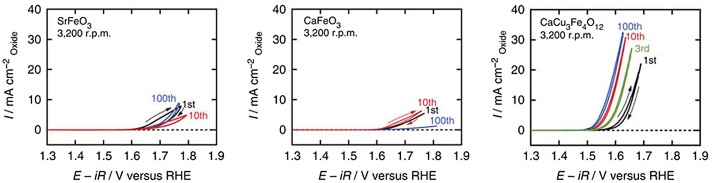
Cyclic voltammograms of SrFeO3, CaFeO3, and CaCu3Fe4O12 for 100 sequential OER measurements. Reproduced from [55].